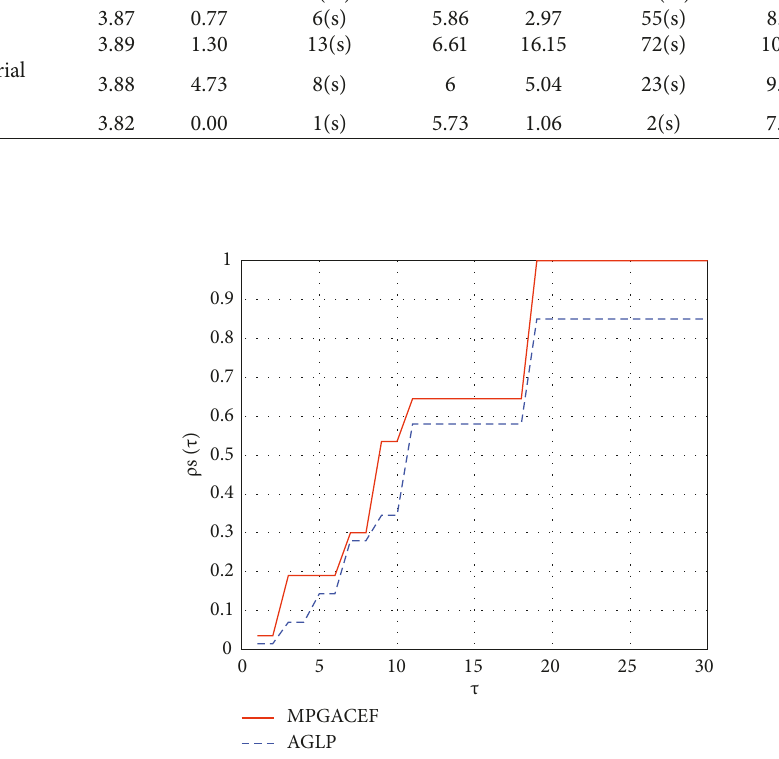
Figure 2: Performance of CPU Time for MPGACEF and AGLP under the condition of